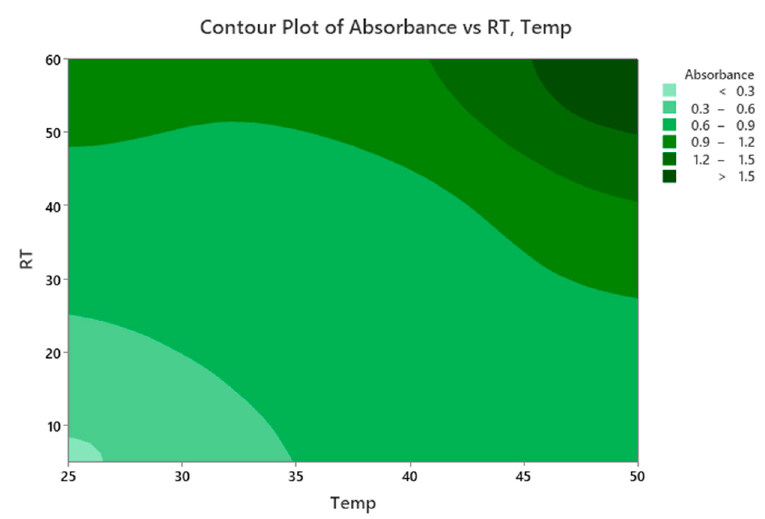
Figure 5. A two-dimensional contour plot for PBD of absorbance versus RT and Temp.